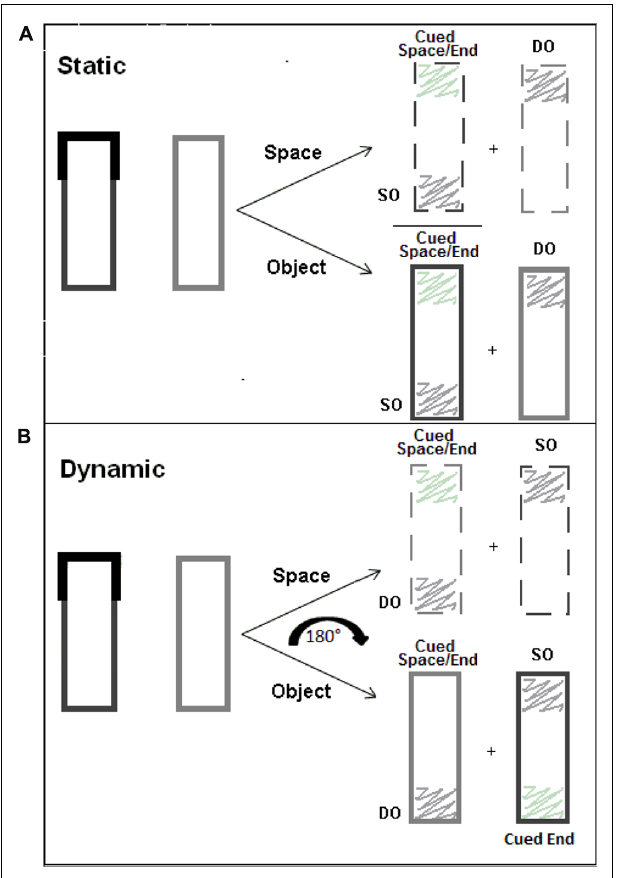
FIGURE 1 | Static (A) and dynamic (B) displays showing the overlap and separation of spatial and object representations (cued space, cued end of the object, same object [SO], different object [DO]). In a static display, cued space and cued end are in the same spatial coordinates, whereas in a dynamic display, they are separated, which allows us to examine their separate attentional